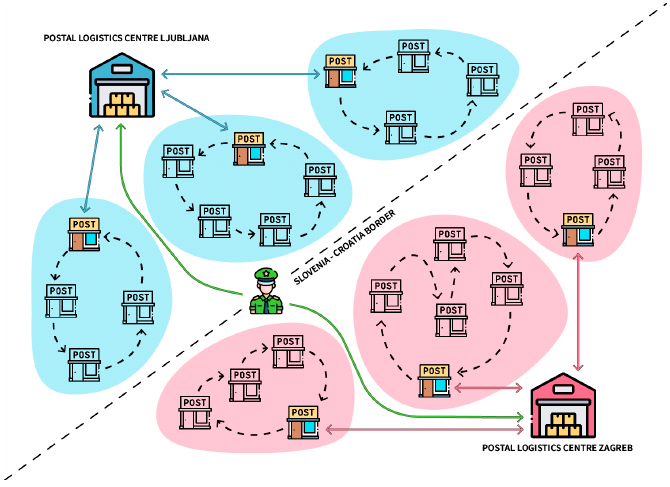
Figure 1. Existing parcel flow in a cross-border region.